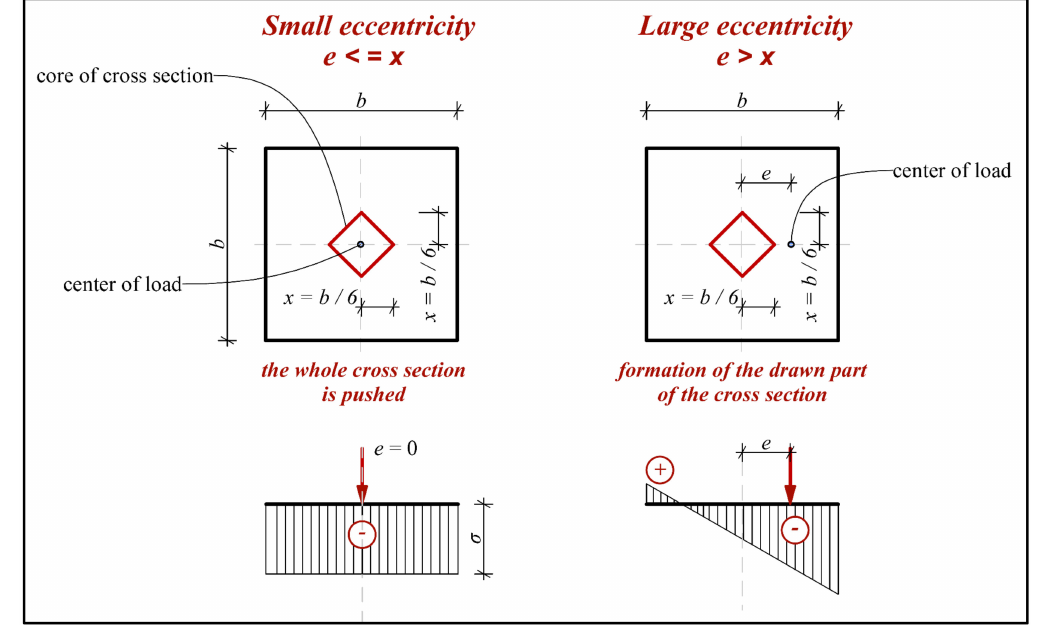
Figure 3. Core of cross section of slab ( e = eccentricity; b = size of slab; x = the distance of the load to the center of the